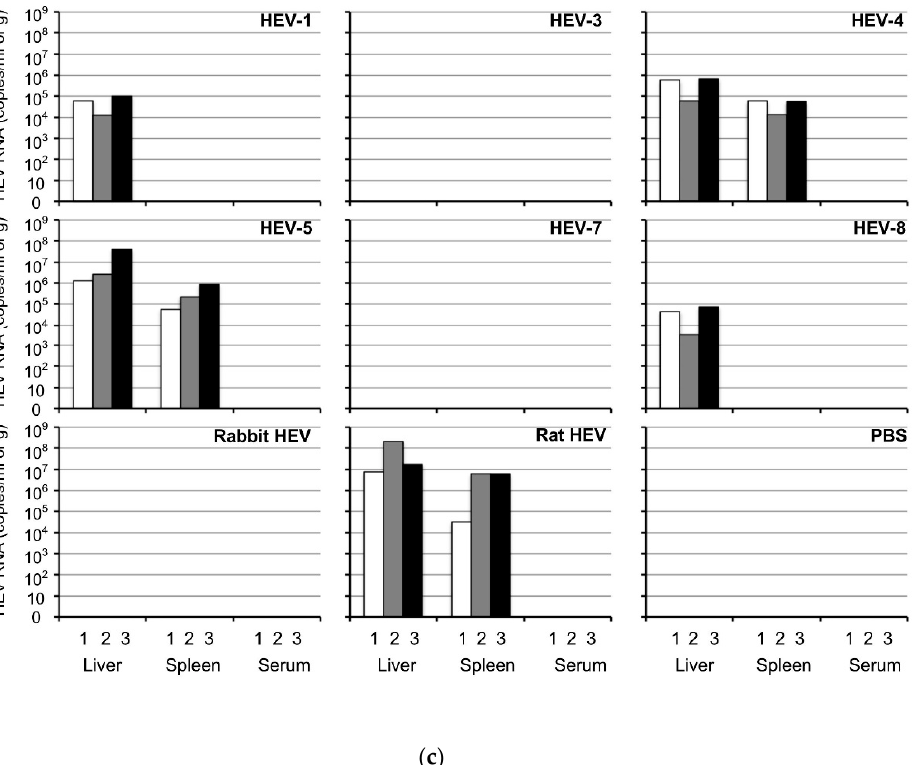
Figure 1. HEV replication in Mongolia gerbils. Twenty-seven Mongolia gerbils were randomly separated into nine groups ( n = 3 per group). Individual gerbils are indicated by , (cid:52) and (cid:3) ( a , b ) or (cid:35) white, gray and black bars ( c ). Each group received HEV-1, HEV-3, HEV-4, HEV-5, HEV-7, HEV-8, rabbit HEV, rat HEV or phosphate-buffered saline (PBS) via intraperitoneal injection. The kinetics of the viral RNA in the fecal specimens were measured by RT-qPCR ( a ). The serum and tissue samples were collected at the end of the experiment (day 28 p.i.), and the anti-HEV-IgG antibody titers were determined using an ELISA with the VLPs of HEV-1 (to detect HEV-1, HEV-3, HEV-4, HEV-5, HEV-7, HEV-8 or rabbit HEV) or those of rat HEV (to detect rat HEV) as the antigens ( b ). Dotted lines: the cut-off values. The minimum endpoints of the antibody titers are blackened ( • , (cid:78) , (cid:4) ) ( b ). The viral RNA titers in the liver, spleen and serum samples ( c When HEV-1 and HEV-8 were used, the maximum titers were <10 5 copies/g, alt- hough the viral RNA was detected from the fecal specimens in all of the inoculated ger- bils. The viral RNA was detected in two of the HEV-3-inoculated gerbils, and one of the RNA was detected in the three rabbit HEV-inoculated gerbils (Figure 1a).